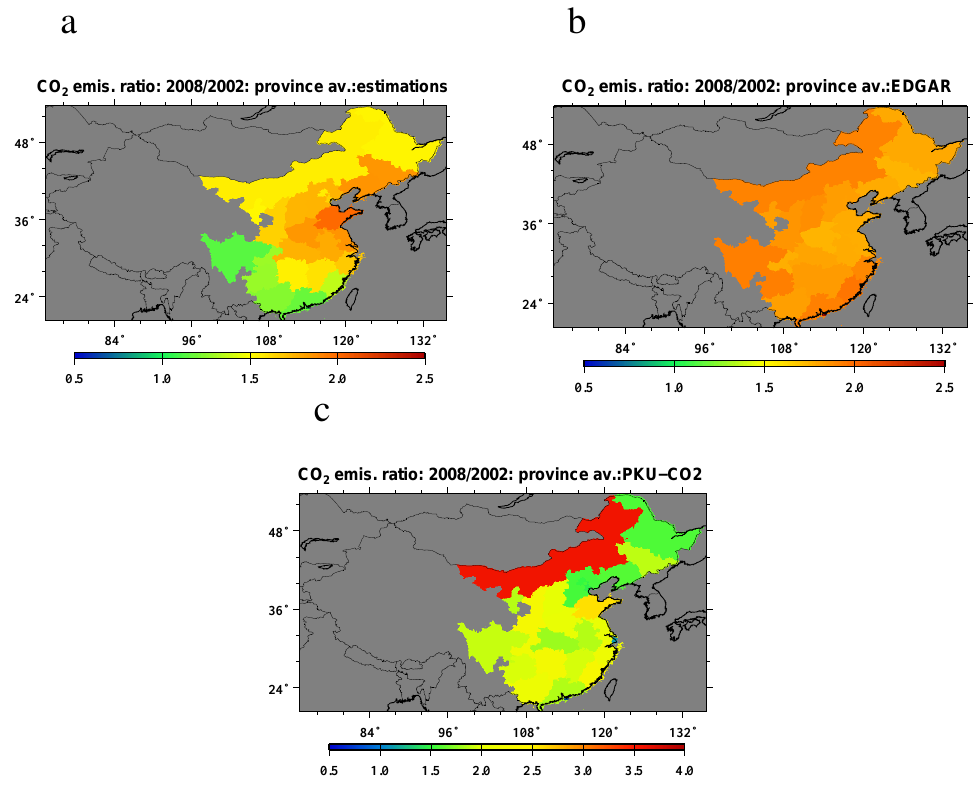
Fig. 9. Magnitudes of the ratio of the top-down satellite-based CO 2 emission estimates in the year 2008 to those in 2002 (a) along with the similar ratios calculated with the EDGAR v4.2 (b) and PKU-CO2 inventories (c) .